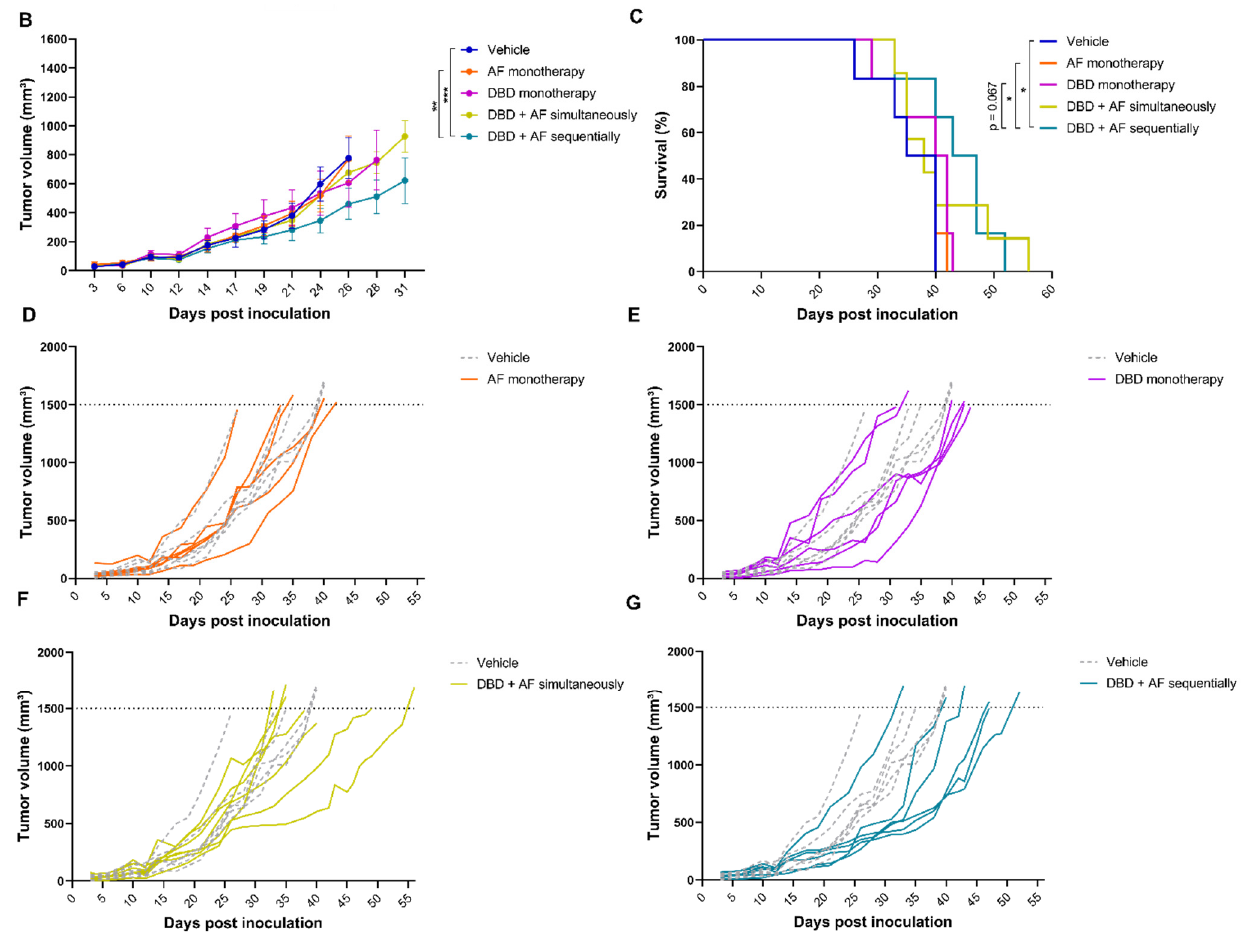
Figure 7. Tumor kinetics and survival after AF and plasma combination therapy. ( A ) Treatment schedule showing timing of AF treatment (15 mg/kg orally administered for 14 consecutive days) with black arrows and cold atmospheric plasma (CAP) treatment (10 s direct application with DBD device for 5 consecutive days) with red arrows. ( B ) Tumor volume kinetics ( n = 6 or 7 mice per group) after treatments as indicated. Data represent mean ± SEM. ( C ) Survival of SB28 mice ( n = 6 or 7 mice per group) after treatments as indicated. ( D – G ) Spaghetti plots of tumor volumes for individual mice in each treatment group (solid lines) compared to individual untreated mice (dotted lines). * p ≤ 0.05; ** p ≤ 0.01; *** p ≤ 0.001 denotes statistically significant differences.